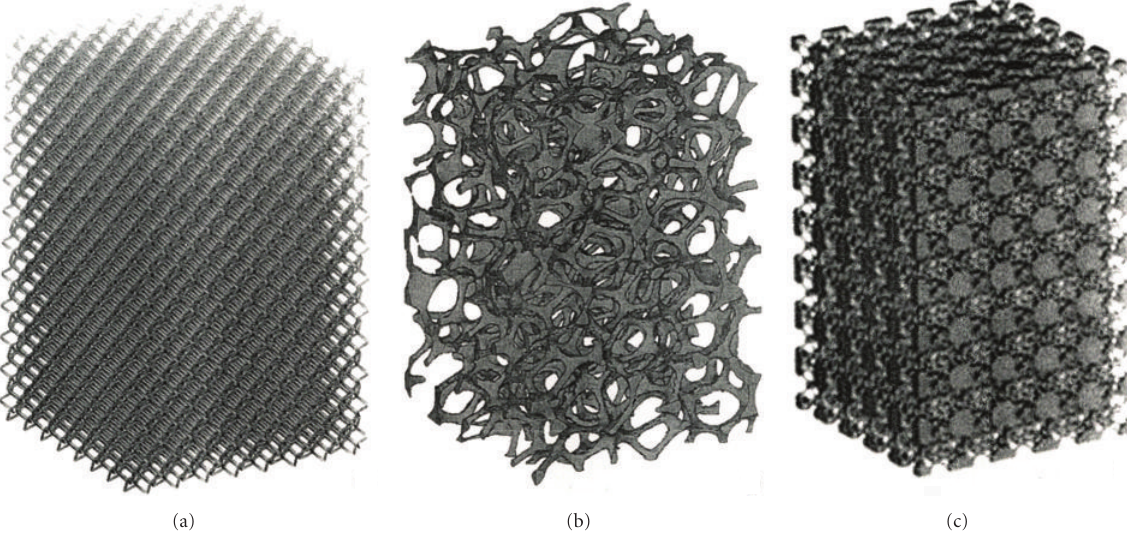
Figure 2: Examples of open-cellular structure CAD models for additive manufacturing using EBM. (a) Dode-thin unit cell/element lattice- mesh structure. (b) Foam structure. (c) Bone unit cell/element lattice structure